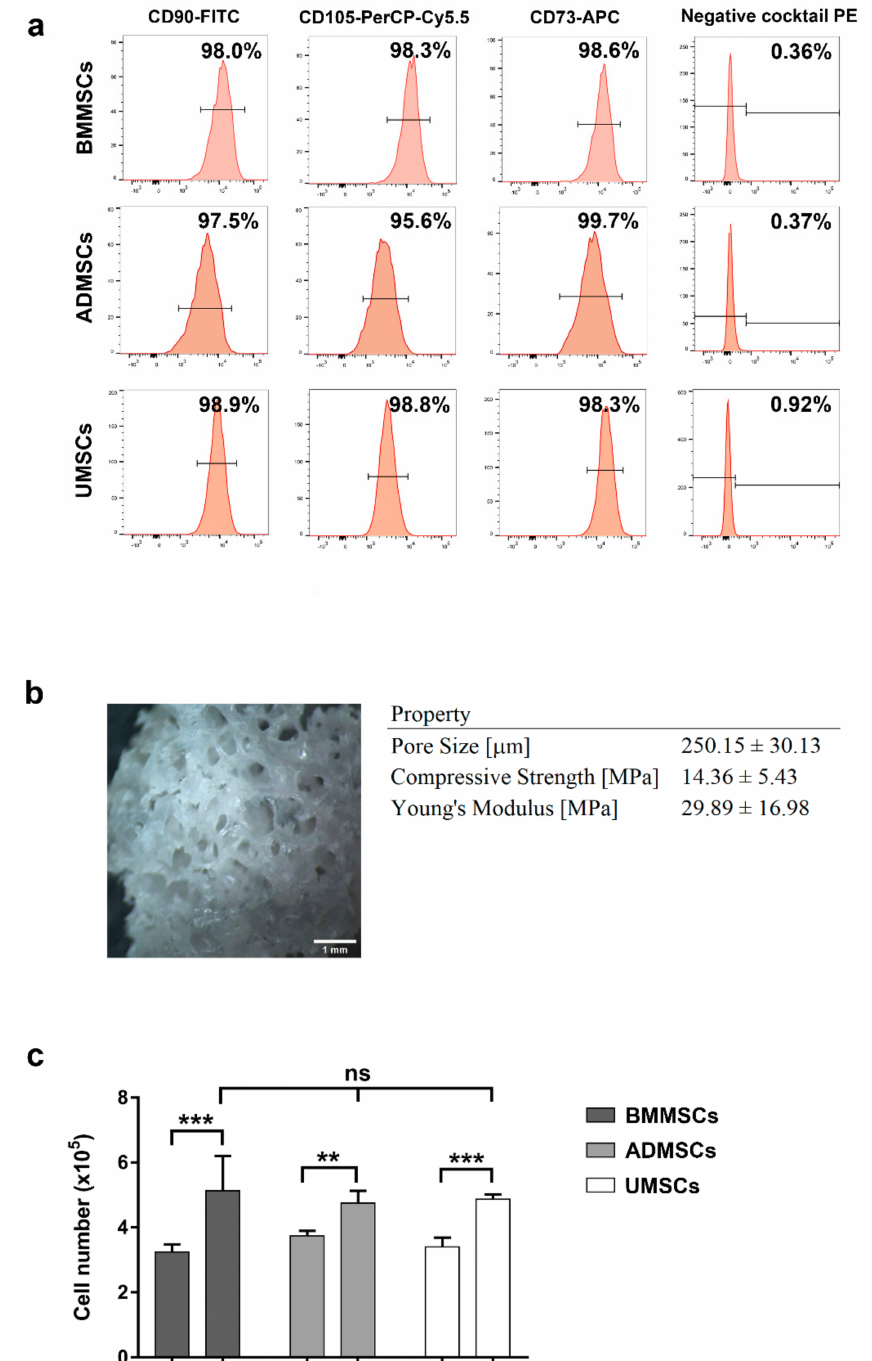
Figure 1. Characterization of hMSCs and hDCB blocks. ( a ) Flow cytometry analysis showed that the late-passage (P7–P10) hMSCs were positive for MSC surface markers (CD90, CD105, and CD73) but negative for hematopoietic markers (negative cocktail PE: CD11b, CD19, CD34, CD45, and HLA-DR). ( b ) Five hDCB blocks from each donor were used to measure the pore sizes and mechanical strength. Results showed the range of pore sizes and mechanical strength. ( c ) Cell viability assay of hMSCs on hDCB blocks was performed on days 1 and 4. Bars represent the mean ± standard error of the mean. A one-way ANOVA with Turkey’s post hoc test was used to examine the differences between experimental groups. Statistical significance is represented as ** p < 0.01, *** p < 0.001, and not significant